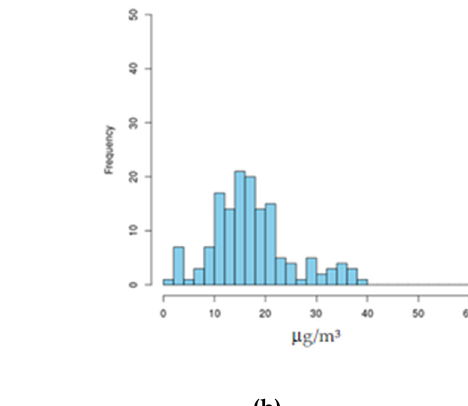
Figure 10. CLE2025 PM 10 : ( a ) ground field of annual average concentration ( μ g/m 3 ); ( b ) frequency distribution of annual average concentration in background stations.